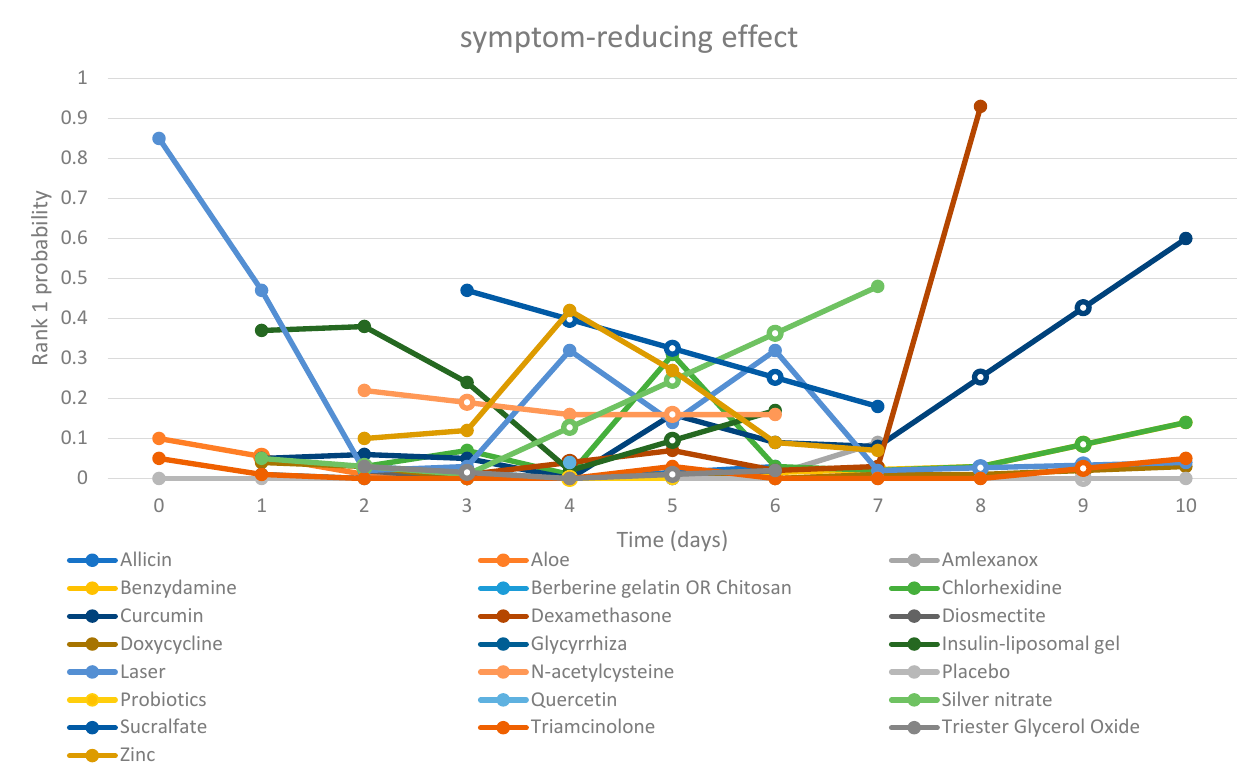
Chart 2. “Time-Rank 1 probability” folding line chart of symptom-reducing effect.